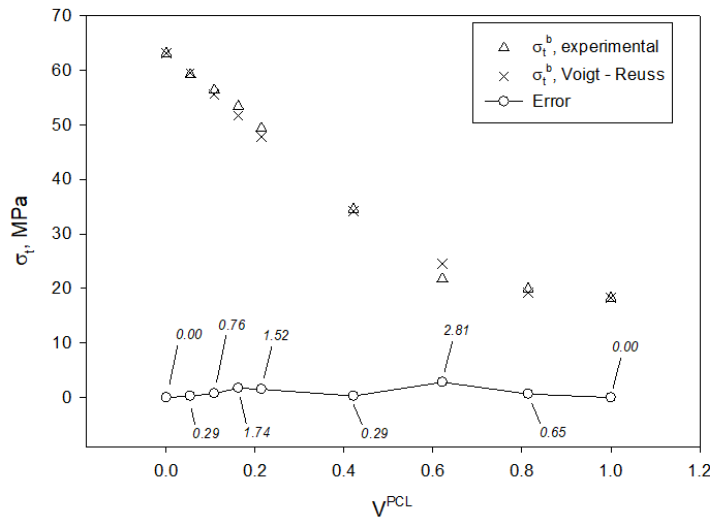
Figure 6. Experimental tensile strength of the PLA / PCL blends compared to the computed values through Voigt-Reuss model.